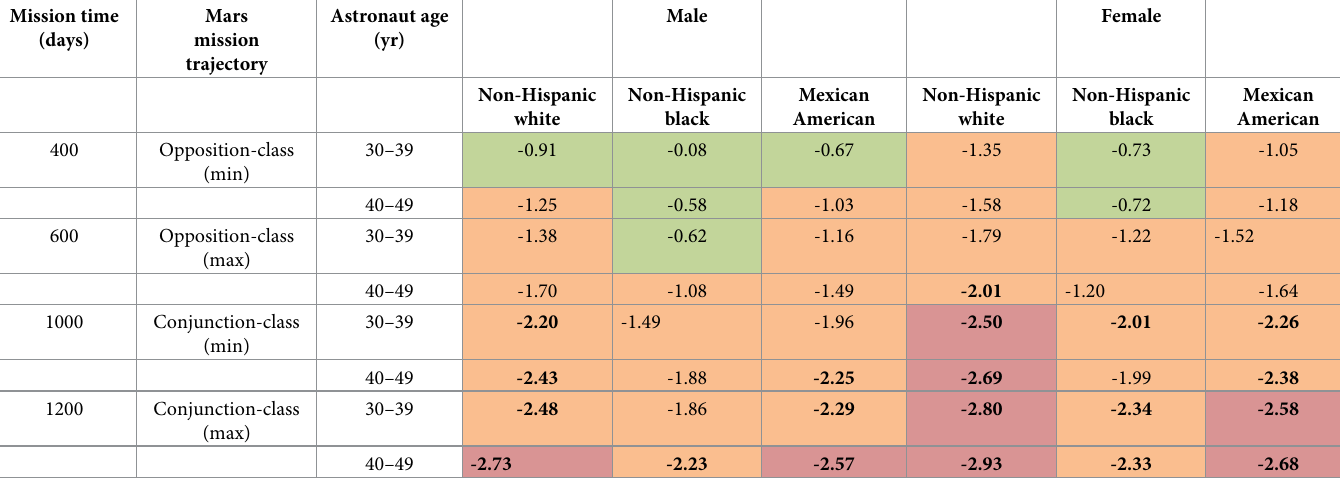
Table 3. Estimated T-scores for each sex/ethnicity/age group. The color code is defined as by the international reference standard, osteoporosis is colored in red (T- score < -2.5), and osteopenia in orange (-2.5 < T-score < -1). Normal T-score is colored in green (T-score > -1). NASA´s non-permissible outcome is T-score < -2, highlighted by bold numbers in the table. Mission time